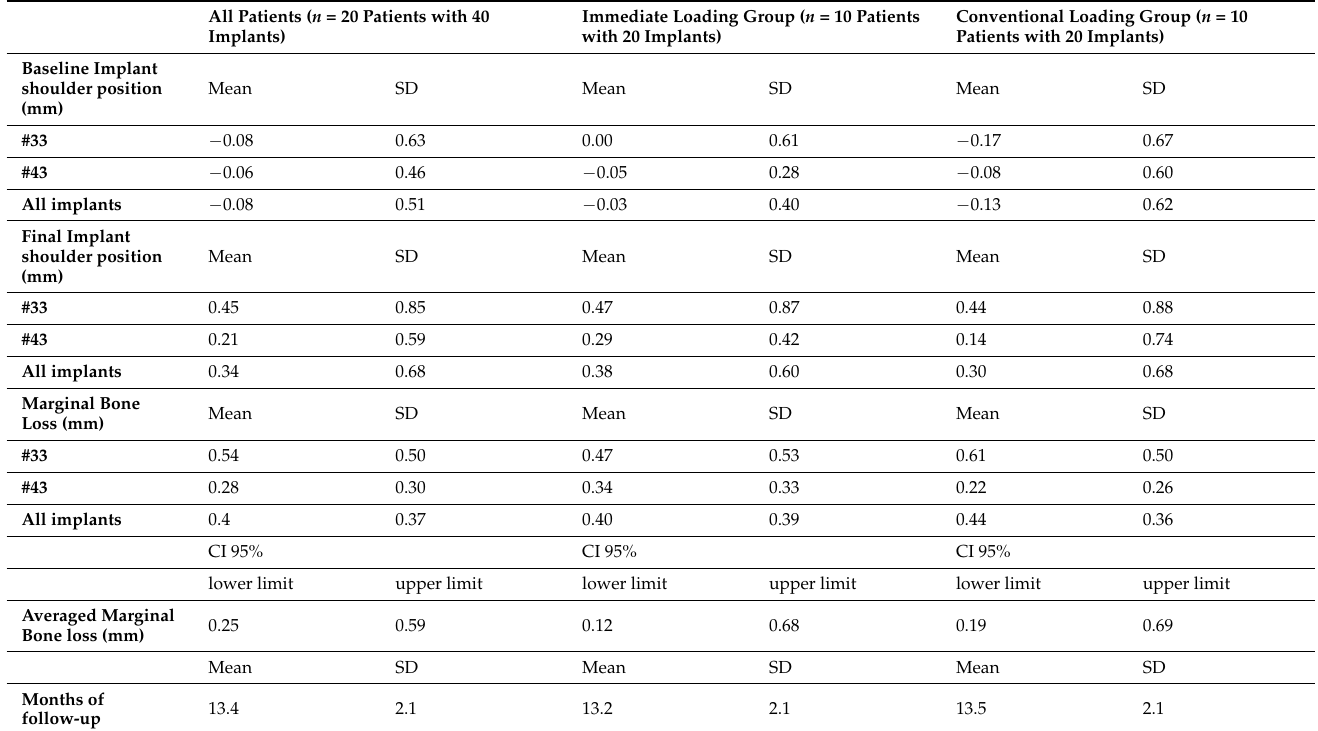
Table 3. Marginal bone loss in the study sample ( n = 20) comparison between conventional